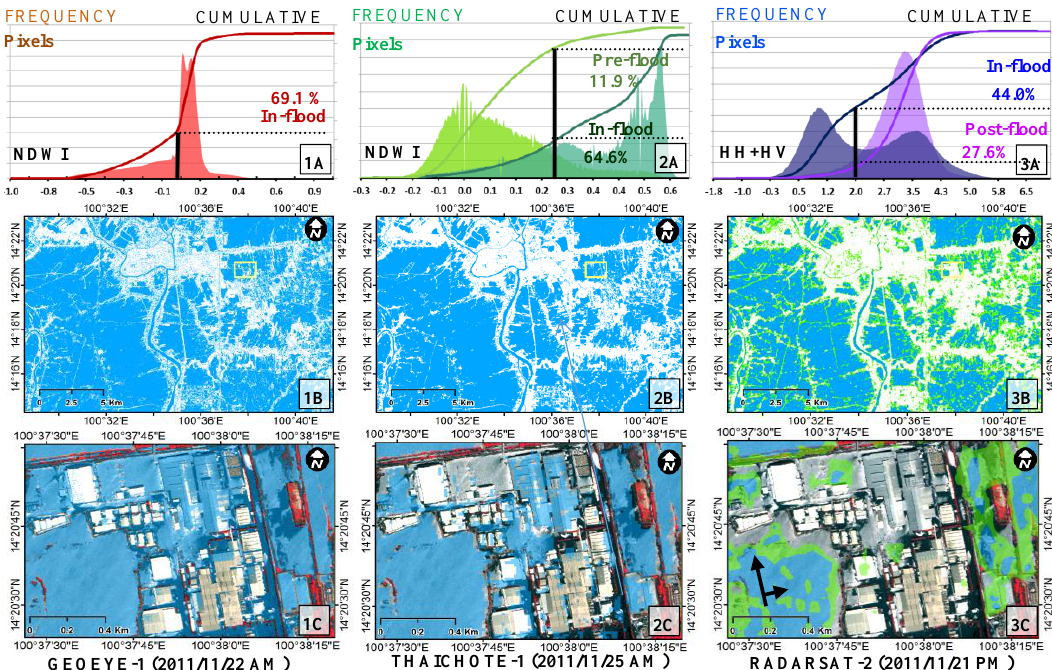
Figure 9. Histograms and cumulative probability plots ( top ) and extracted flooded areas (blue color) in Ayutthaya city ( middle ) and over part of the Rojana Industrial Park ( bottom ), from the visualization of the GeoEye-1 image ( 1A – 1C ), determining the best accuracy of the ThaiChote-1 image ( 2A – 2C ), and the emphasis of the neighborhood valley on the RADARSAT-2 image ( 3A – 3C ), plotted on a GeoEye-1 false color composite. The green pixels are the determined best accuracy results from RADARSAT-2, which was larger than that determined using the neighborhood valley-emphasis method.